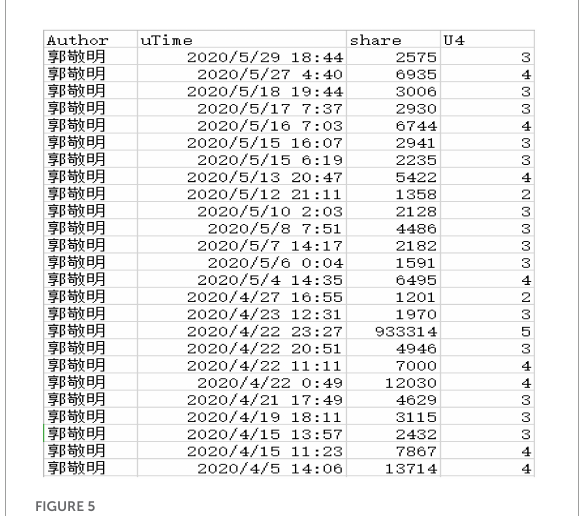
FIGURE5 Assignment of the number of transmissions of some celebrity Microblog users.